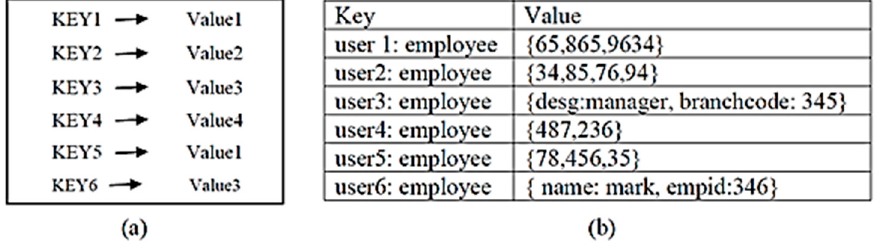
Figure 2. ( a ) Key-value store (KVS) data model, ( b ) Data in Figure 2. (a) Key-value store (KVS) data model , (b) Data in KVS.